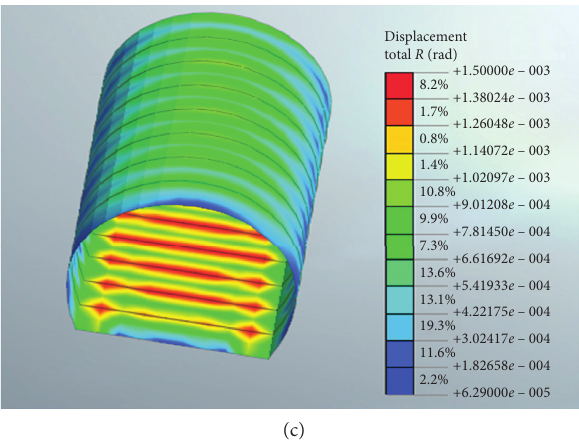
Figure 11: Cloud image of maximum displacement of the shotcrete layer. (a) After the third blasting. (b) After the fourth blasting. (c) After the fifth